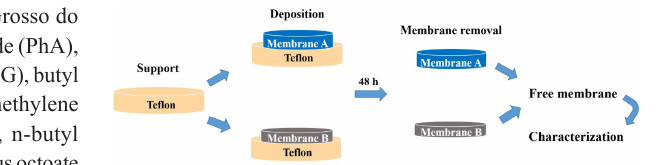
Figure 1. Scheme to obtain the free membranes A and B